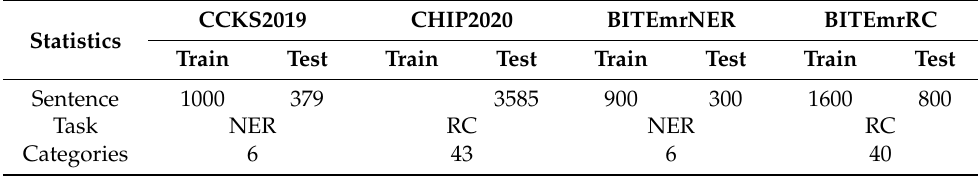
Table 3. Statistics of